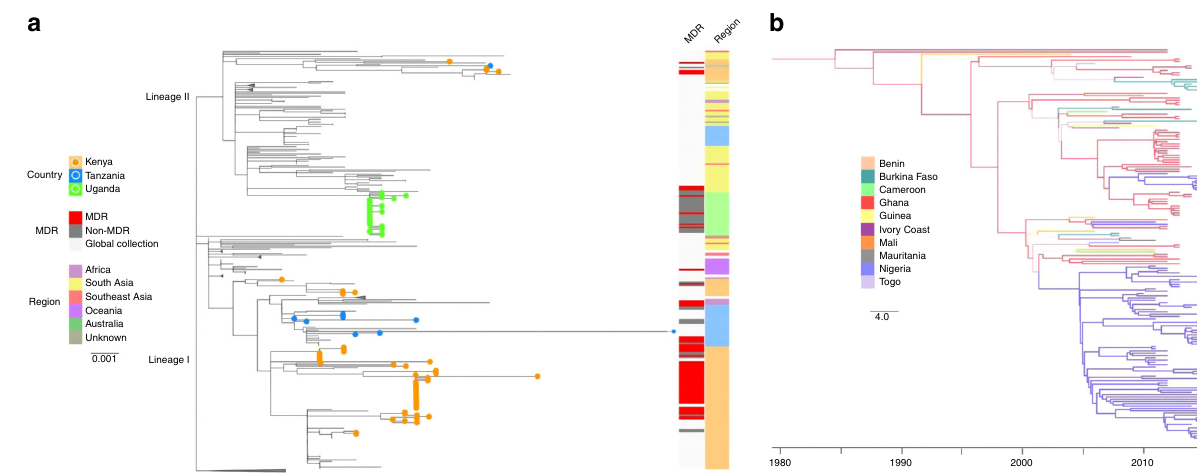
Fig. 3 The phylogenetic structures of the major Salmonella Typhi genotypes in sub-Saharan Africa. a Maximum likelihood tree of genotype 4.3.1 S . Typhi isolates from this study in the context of other global genotype 4.3.1 S . Typhi isolates; the two distinct sub-lineages are labeled at the base of the tree. 4.3.1 S . Typhi isolates from this study (Kenya, Tanzania, and Uganda) are highlighted in corresponding coloured branches and circles at the tip of each tree. The fi rst coloured bar shows the MDR phenotypes of study isolates. The second coloured bar outlines the continents and African regions where 4.3.1 S . Typhi have been detected. Scale bar indicates the number of substitutions per variable site; nodes of the tree have been collapsed for better visualization. b Maximum clade credibility tree (reconstructed using BEAST2) of genotype 3.1.1 S . Typhi isolates from this study in the context of other global genotype 3.1.1 S . Typhi isolates. Tree shows a phylogeographical reconstruction of genotype 3.1.1 S . Typhi isolates in West Africa. Branches are weighted by the support for the location changes; thicker branches have higher support. Branches and nodes are coloured according to the location that had the highest posterior probability values for some nodes of the tree. The scale bar indicates the number of substitutions per